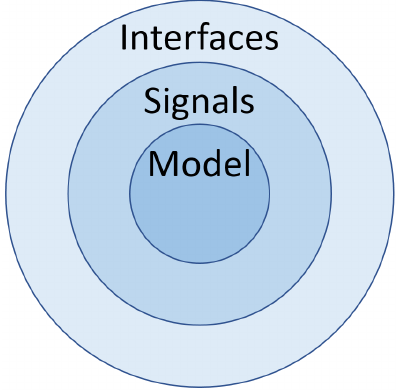
Figure 2. Multi-layer concept following the onion architecture. [Source: Own